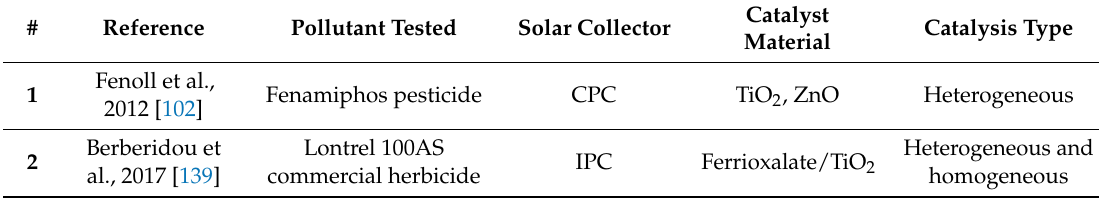
Table 5. BROCs model wastewaters (Pesticides).